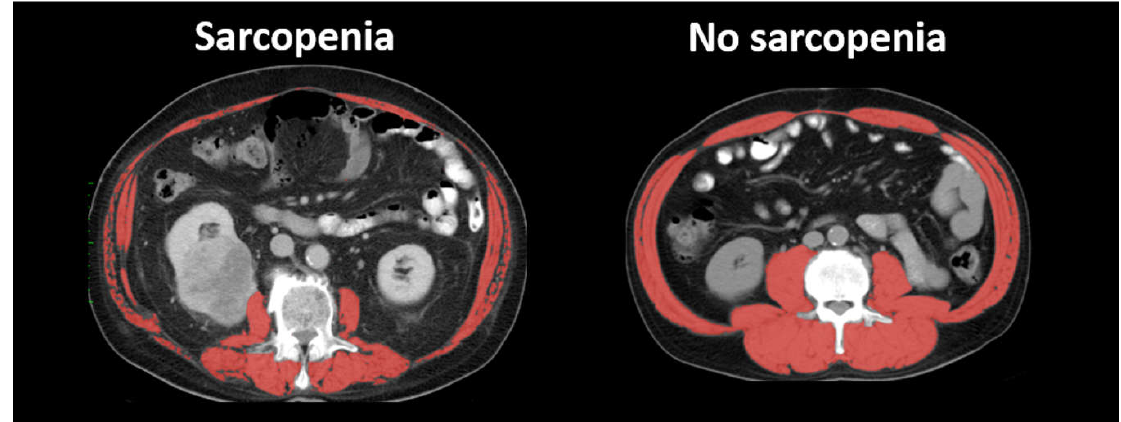
Figure 1. Computed tomography (CT) images of typical sarcopenic and non-sarcopenic cases. Skeletal muscle area is shown in red.